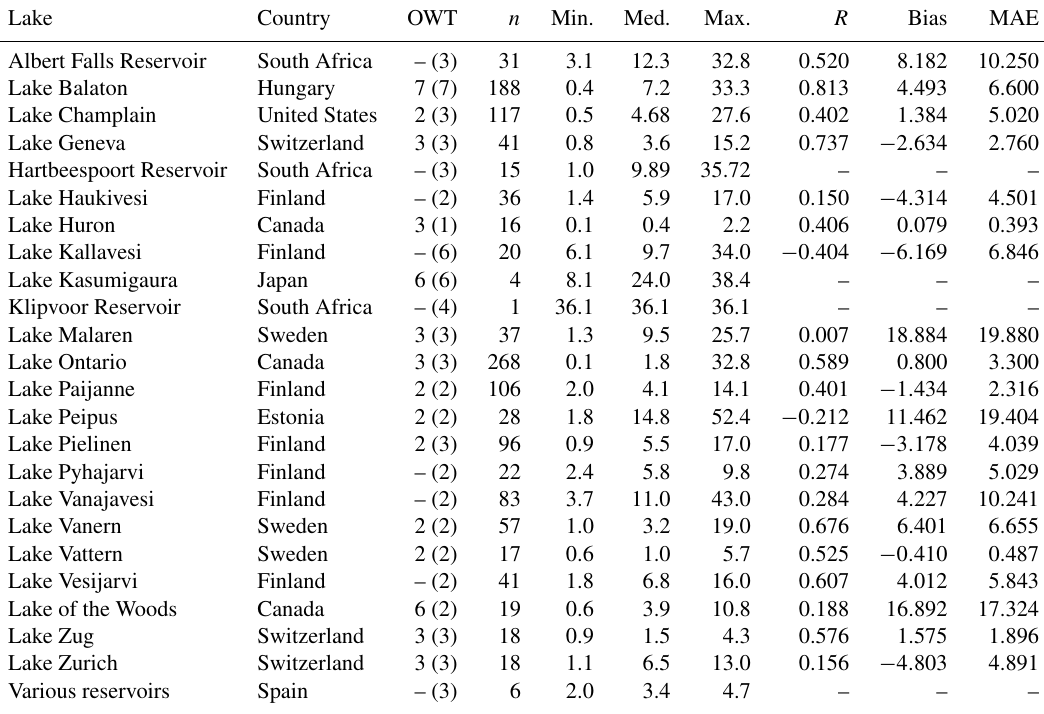
Table 3. Statistical metrics and ancillary information for chl- a matchup data and the FUB algorithm. n/Min./Med./Max. represent the in situ measurement counts and ranges represented by the matchups for all n > 15. OWT are indicated as the mode of the 9-year averaged products where available, as well as for the available matchup data for FUB (in